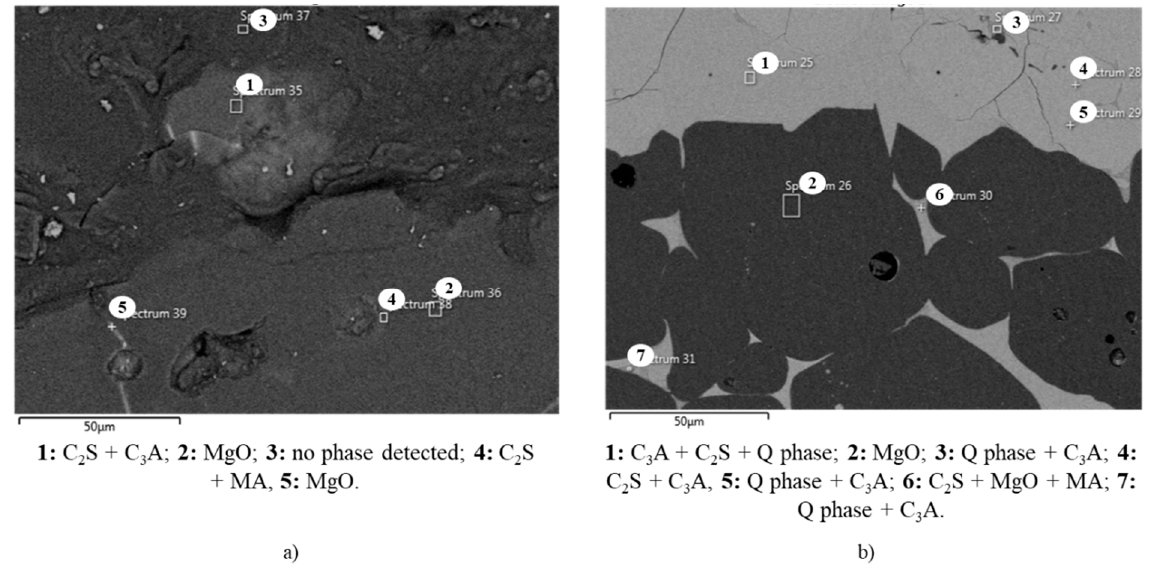
Figure 9. SEM micrograph of the clinker–brick interface of composition: ( a ) A-1, ( b ) A-3 after the sandwich coating test—700× magnification.